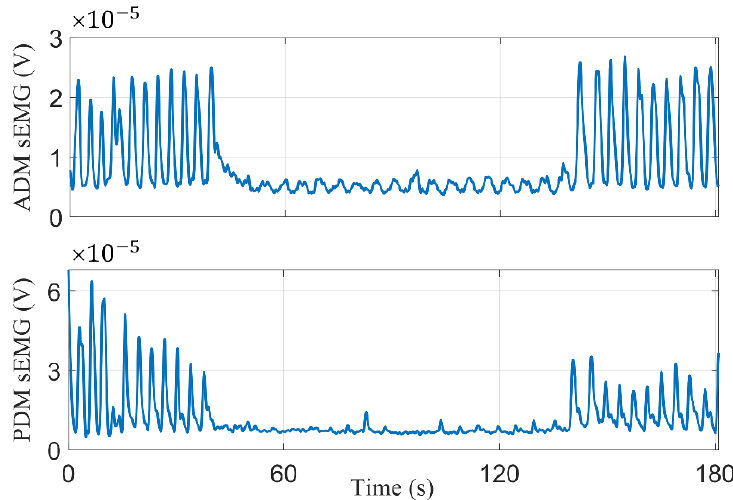
Figure 14. sEMG of ADM and PDM.